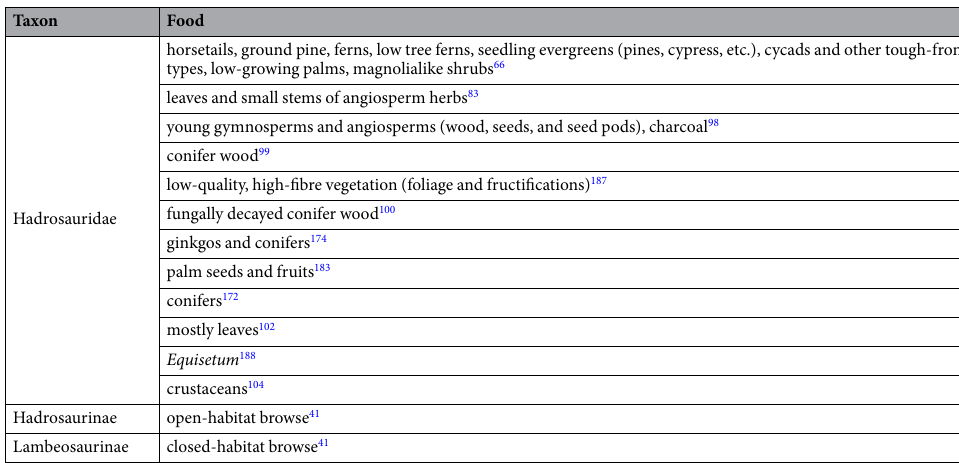
Table 3. Non-exhaustive survey of inferred foodstuffs for megaherbivorous dinosaurs present in the Dinosaur Park